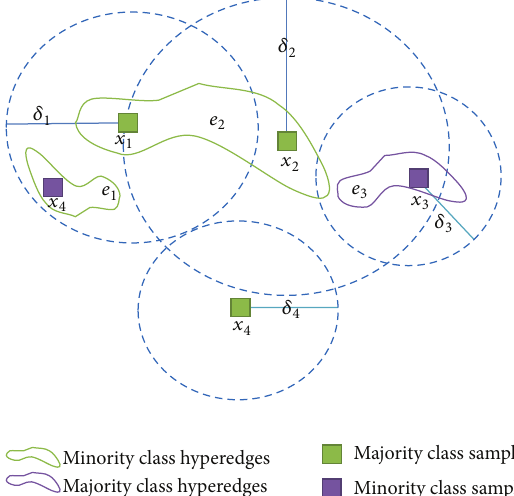
Figure3:Anexampleofupper,lowerapproximation,andboundary